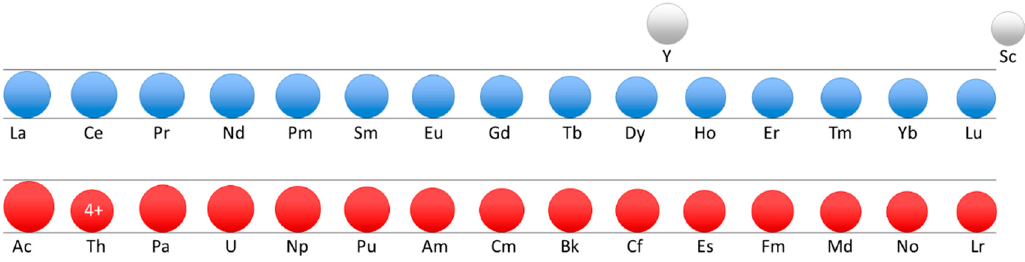
Figure 1. The ionic radii of the 6-coordinate M 3+ cations of the rare earth and actinide metals (except for Th which is Th 4+ ) [11–13].